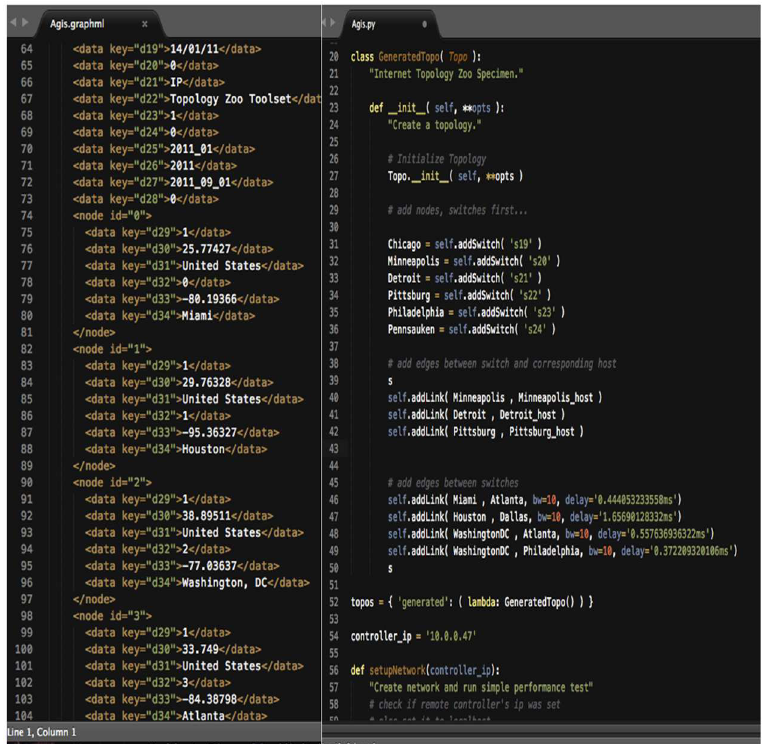
Fig 5. Agis topology in graphml and python script.